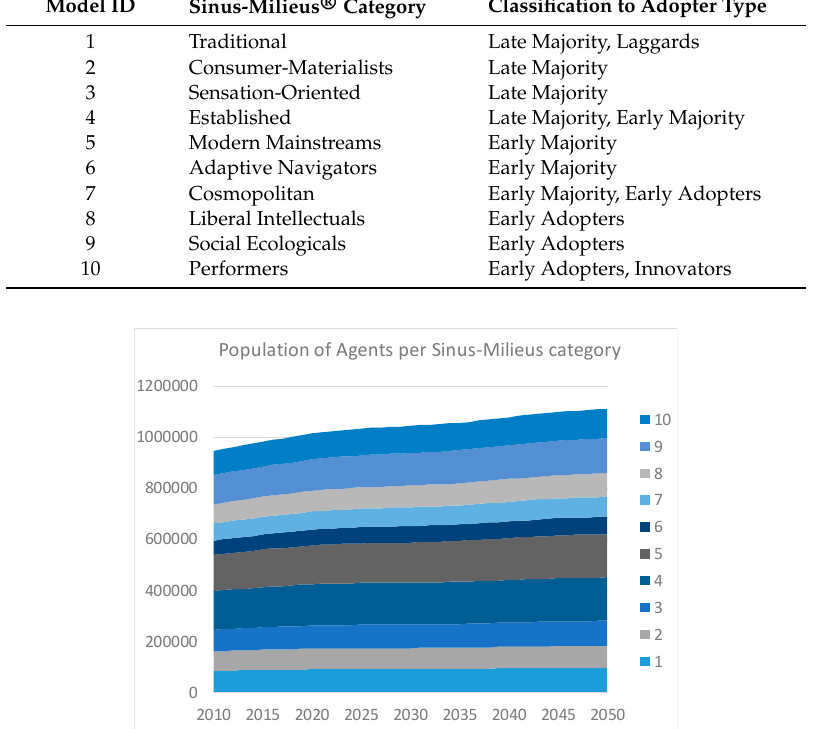
Figure 5. Population of agents (i.e., evolution of single- and two-family houses in Switzerland) per Sinus-Milieus ® category; for a mapping to the IDs reported in the figure to the Sinus-Milieus ® category, please see Table